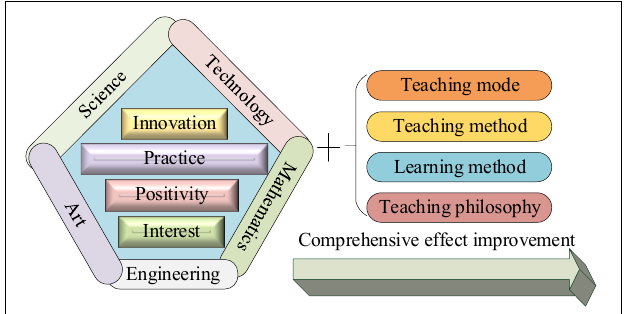
FIGURE 2 | The impact of Science, Technology, Engineering, Art, and Mathematics (STEAM) teaching mode on English grammar teaching in high